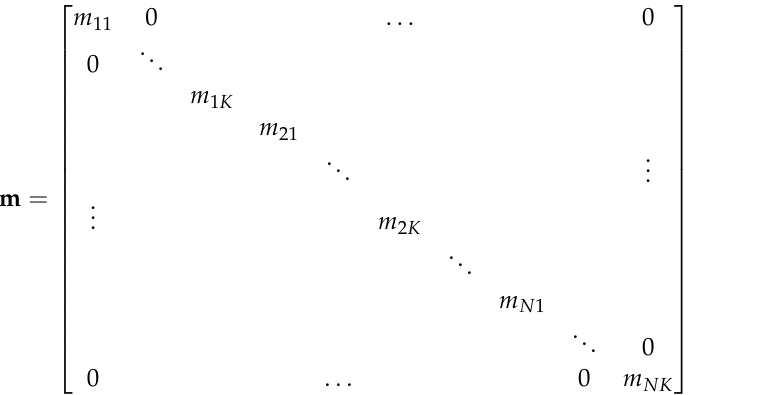
Figure 1. FE model of a generic structure with the inclusion of MTMD.